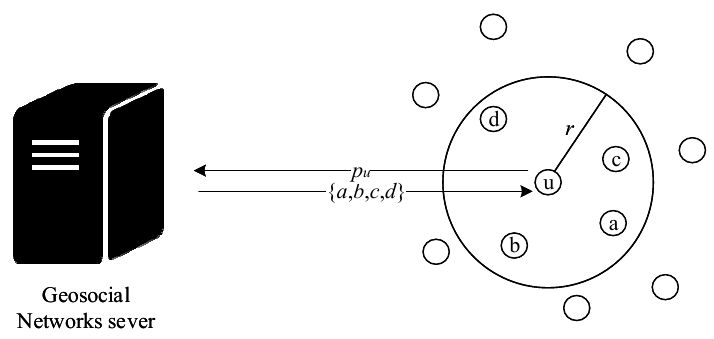
Figure 4. Schematic diagram of Location Sharing Mechanisms.